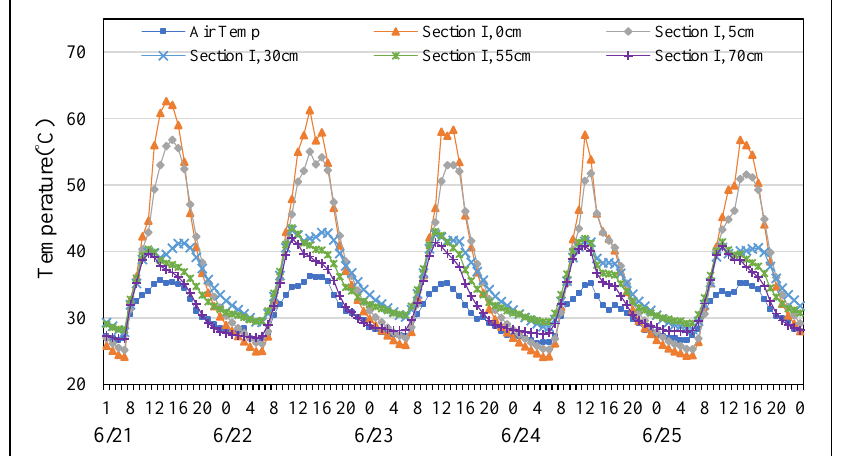
Figure 6. Temperature distribution at each depth of Section I from the 21st to the 25th of June.